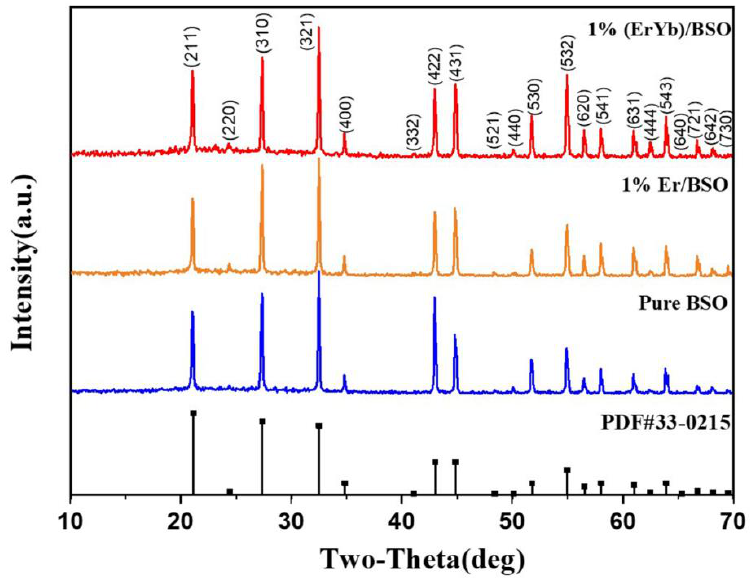
Figure 3. X-ray diffraction patterns of pure BSO, Er: BSO, and Er/Yb: BSO powders. The doping concentrations of Er 3+ and Yb 3+ were measured by ICP-AES spectrometer. The concentration of Er 3+ in the Er: BSO crystal was 1.26 at%, and the concentrations of Er 3+ and Yb 3+ in the Er/Yb: BSO crystal were 0.19 at% and 0.73 at%, respectively. According